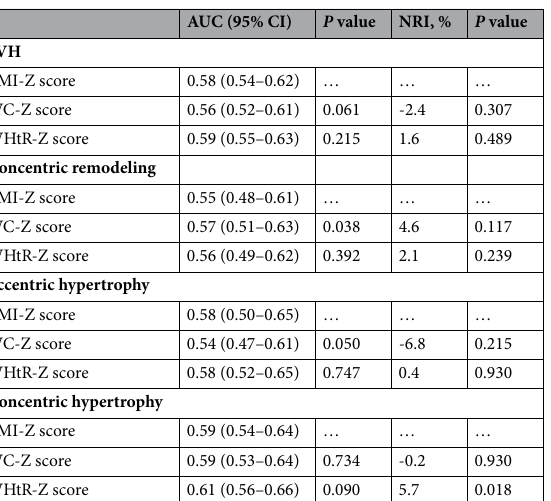
Table 3. Performance of BMI, WC and WHtR to predict LVH and LVG in hypertensive youth. AUC, area under the curve; LVH, left ventricular hypertrophy; LVG, left ventricular geometry; BMI, body mass index; WC, waist circumference; WHtR, waist-to-height ratio; NRI, net reclassification improvement.